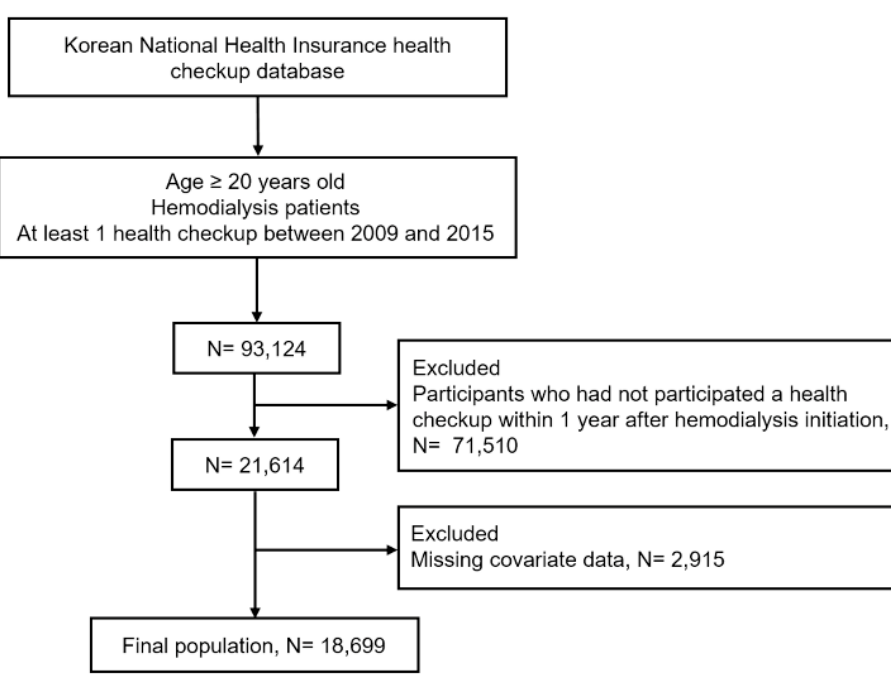
Figure 1. Flow chart of the study population.